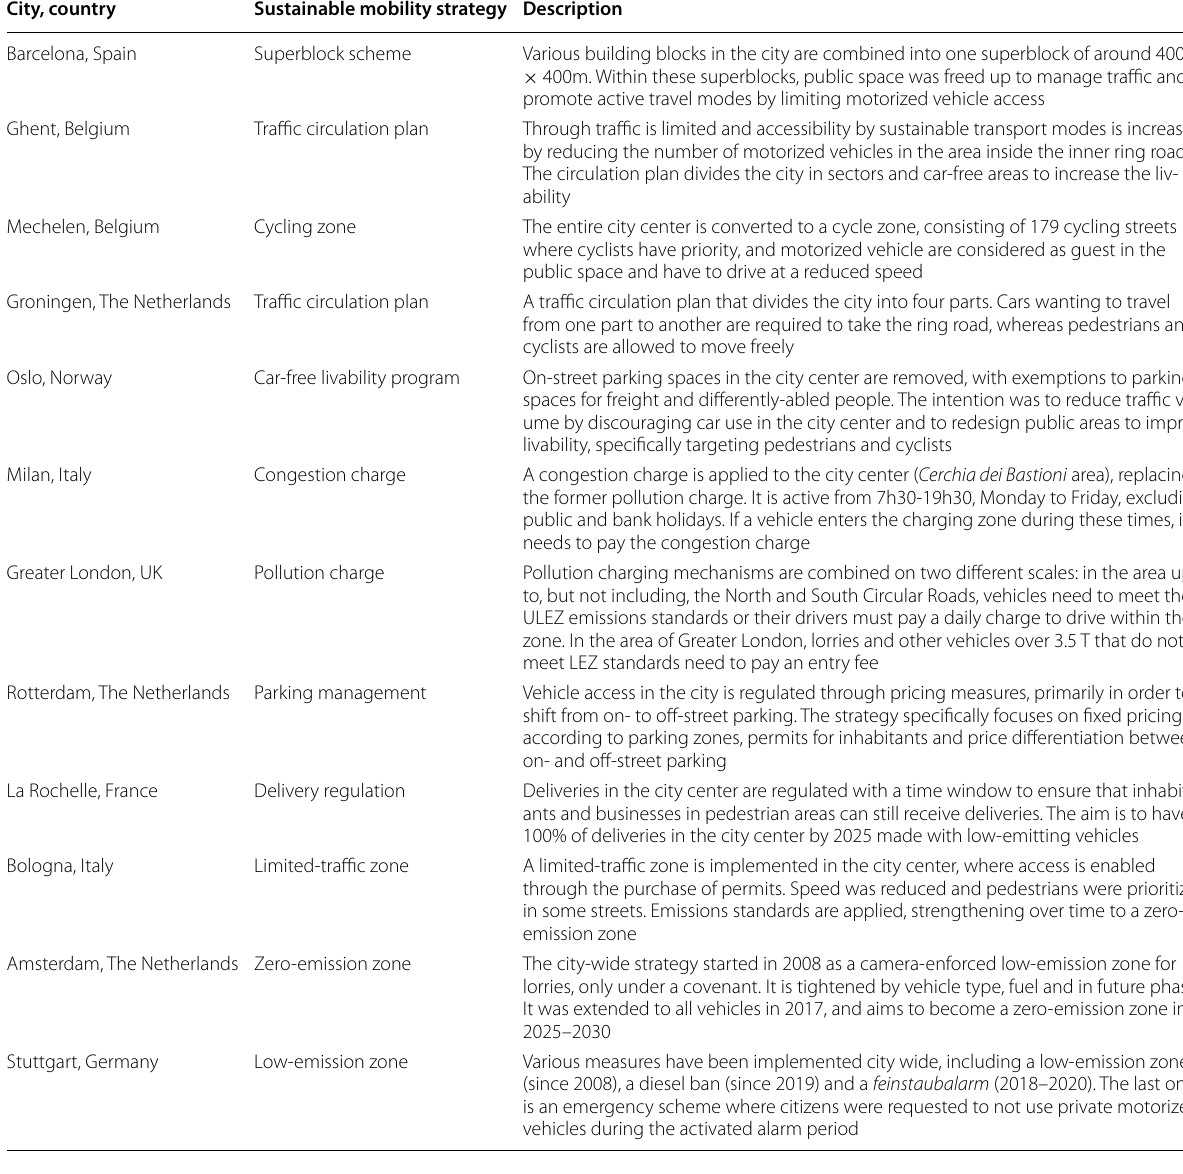
Table 1 Short summary of the 12 case study cities and their respective sustainable mobility strategies City, country